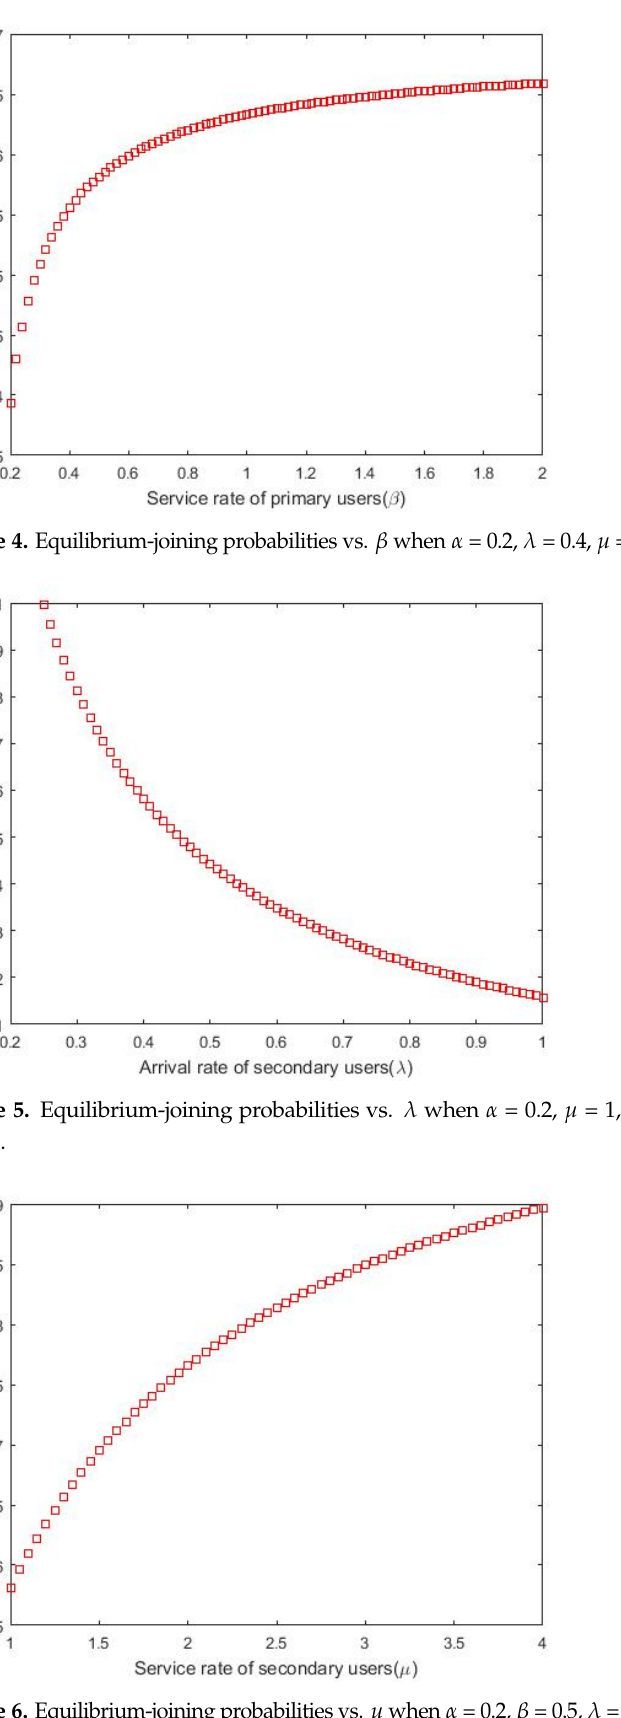
Figure 6. Equilibrium-joining probabilities vs. µ when α = 0.2, β = 0.5, λ = 0.4, θ = 0.7, η = 0.5, C = 1, R =